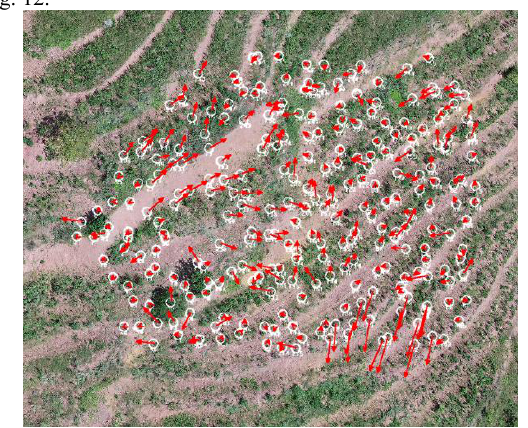
Table 2 . Displacement of GNSS calibration